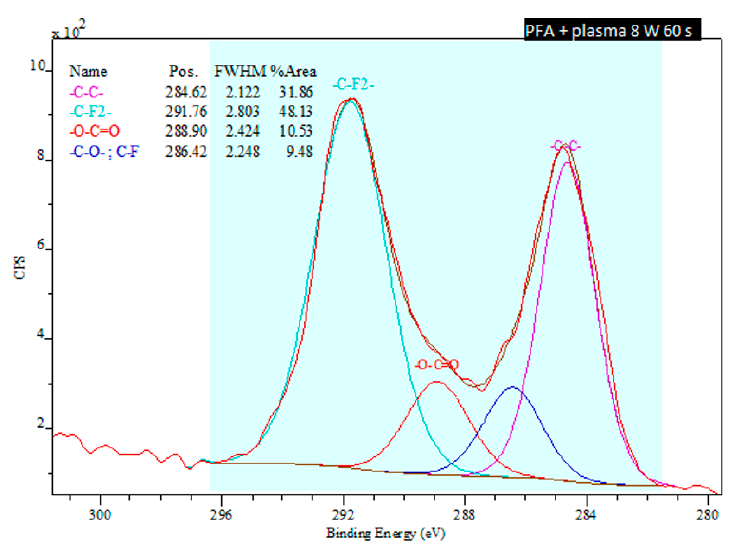
Figure 9. Deconvoluted spectra from an XPS analysis of a plasma-treated PFA sample exposed to 8 W for 60 s.